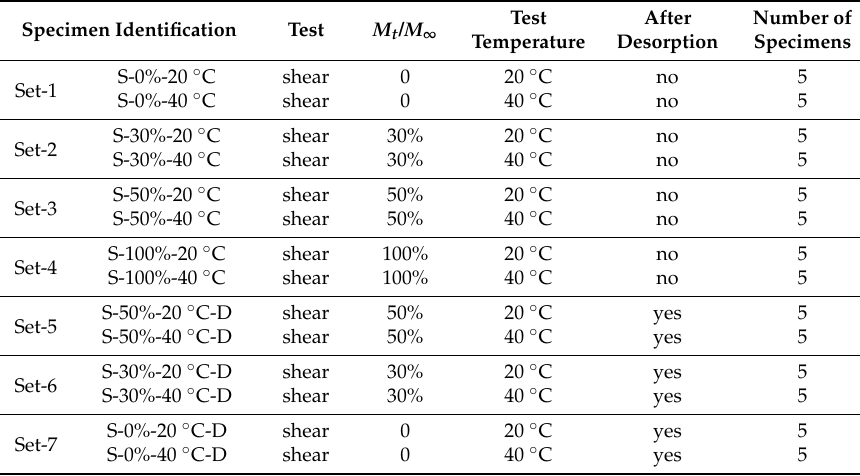
Table 3. GFRP laminate specimens for short-beam shear